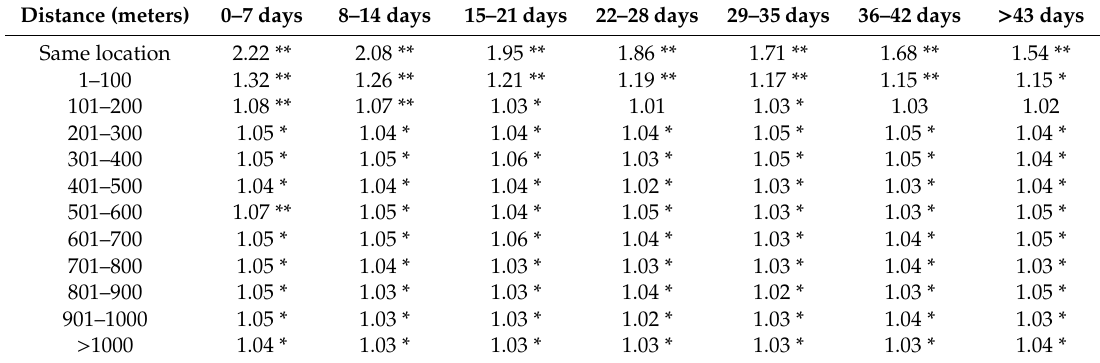
Table 2. RNR matrix of VMVT.